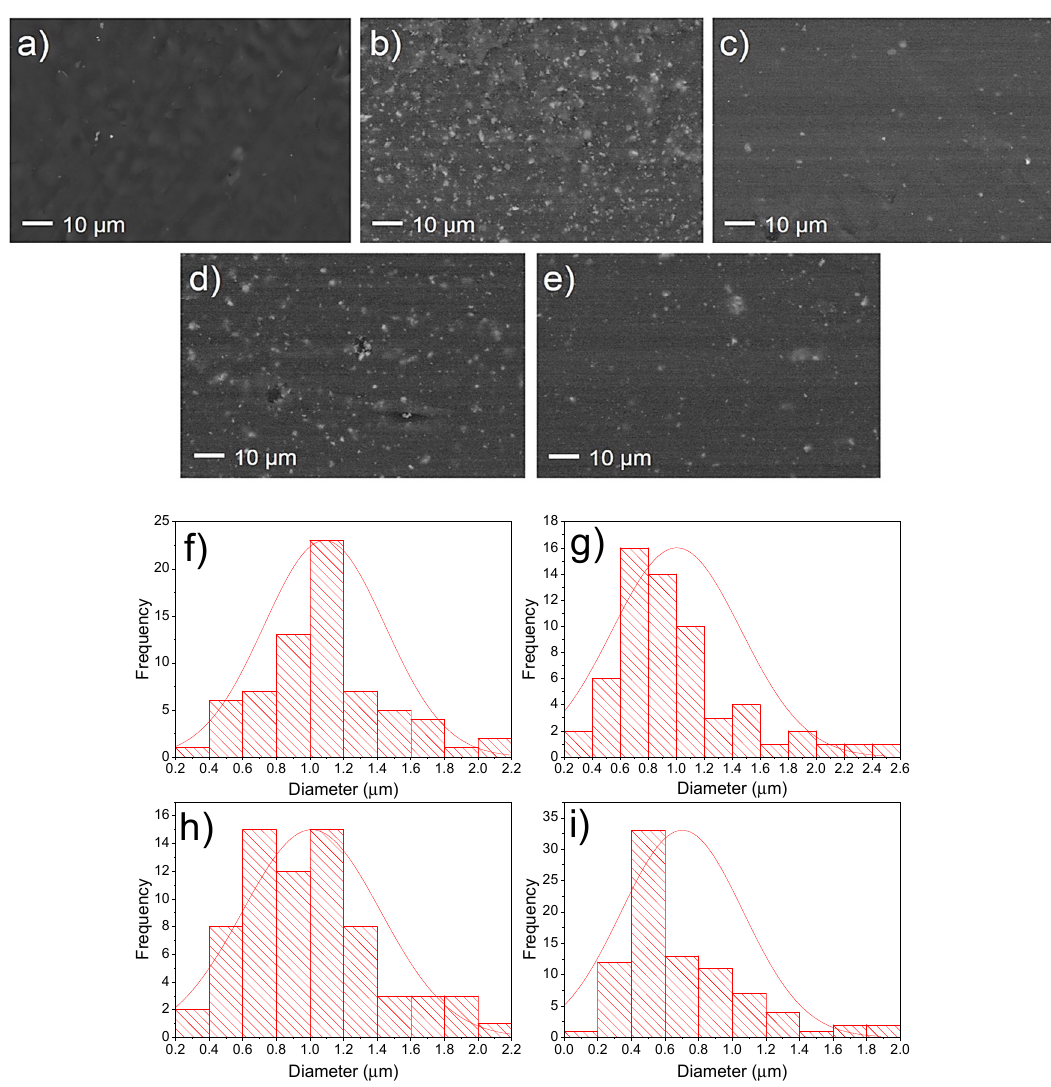
Figure 4. SEM images of ( a ) LDPE, ( b ) LDPE 5% CaO 55 nm, ( c ) LDPE 5% Mod-CaO 55 nm, ( d ) LDPE 5% CaO 25 nm, and ( e ) LDPE 5% Mod-CaO 25 nm. Histograms of SEM images ( f ) LDPE 5% CaO 55 nm, ( g ) LDPE 5% Mod-CaO 55 nm, ( h ) LDPE 5% CaO 25 nm, and ( i ) LDPE 5% Mod-CaO 25 nm.